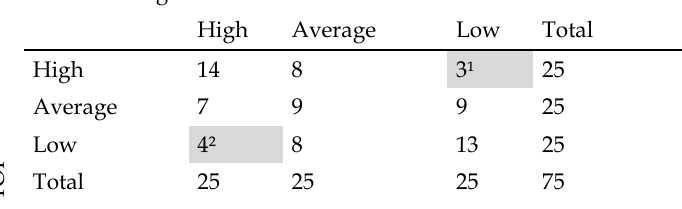
Table 3.Cross-tabulations between the transport opportunity score (TOI) and the relative weights of the